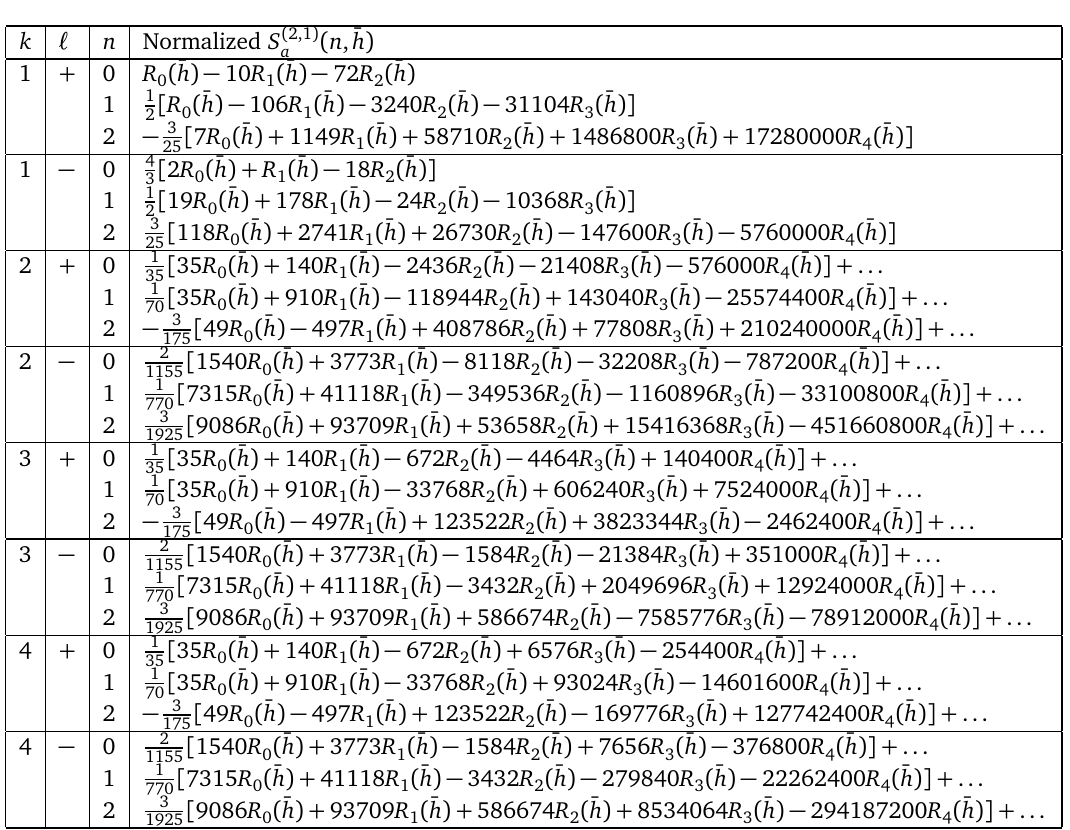
Table 7: Expressions for S ( 2,1 ) pole in (2.31). For k = 1 they have been found exactly while for k > 1 we give the first five terms in the asymptotic series which is valid for large ¯ h ( ¯ h − 1 ) . This time, the appropriate formula depends on whether it is being used to compute an even-spin or odd-spin